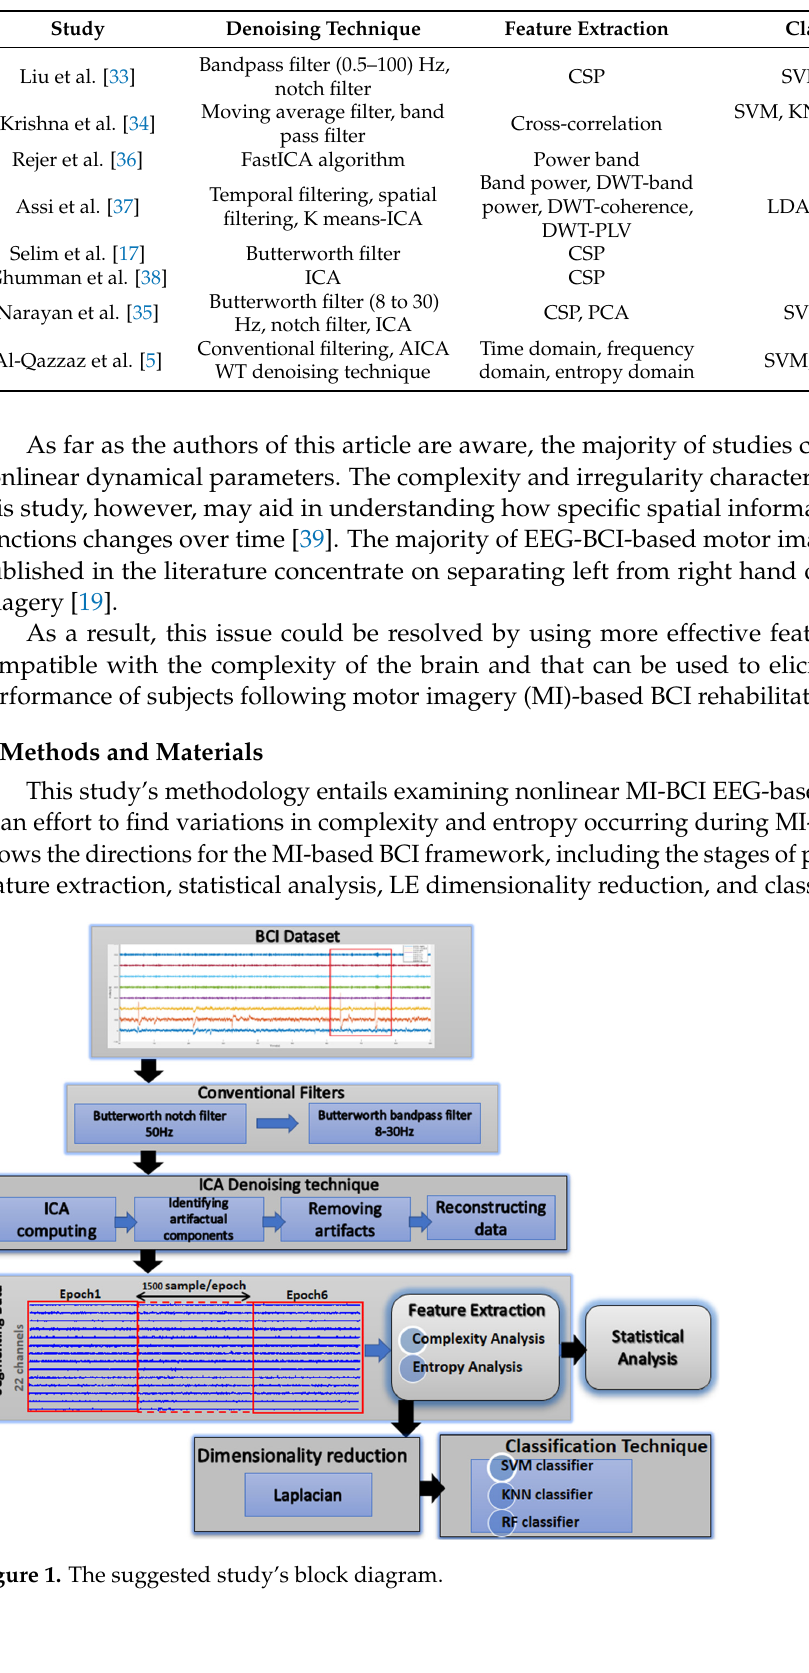
Table 1. State-of-the-art: various denoising, feature extraction, and classification approaches are used in EEG analysis for MI-based BCI.